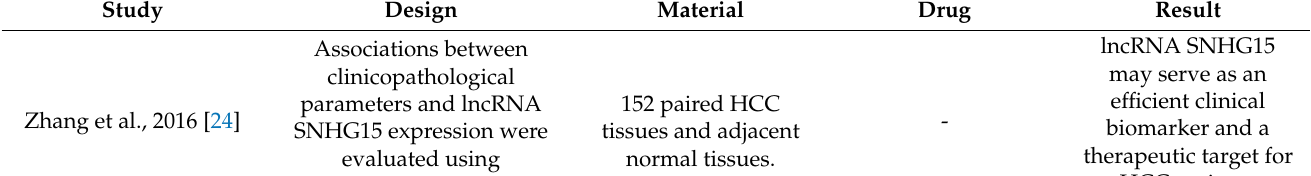
Table 1. Clinical trials on SNHG15 in hepatocellular